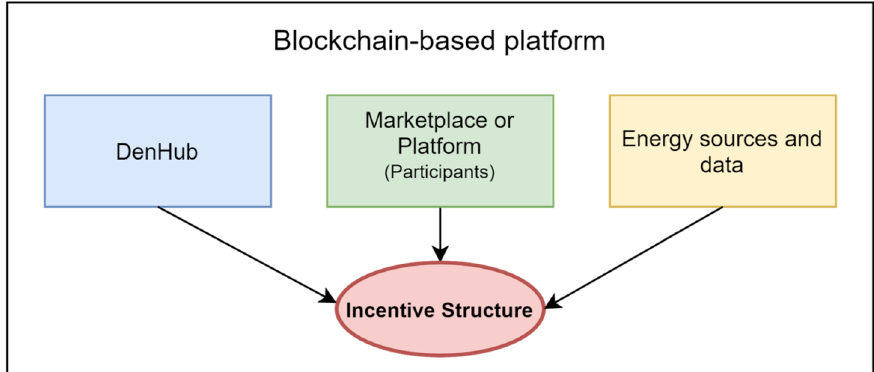
Figure 4. Incentive Structure of the Blockchain.